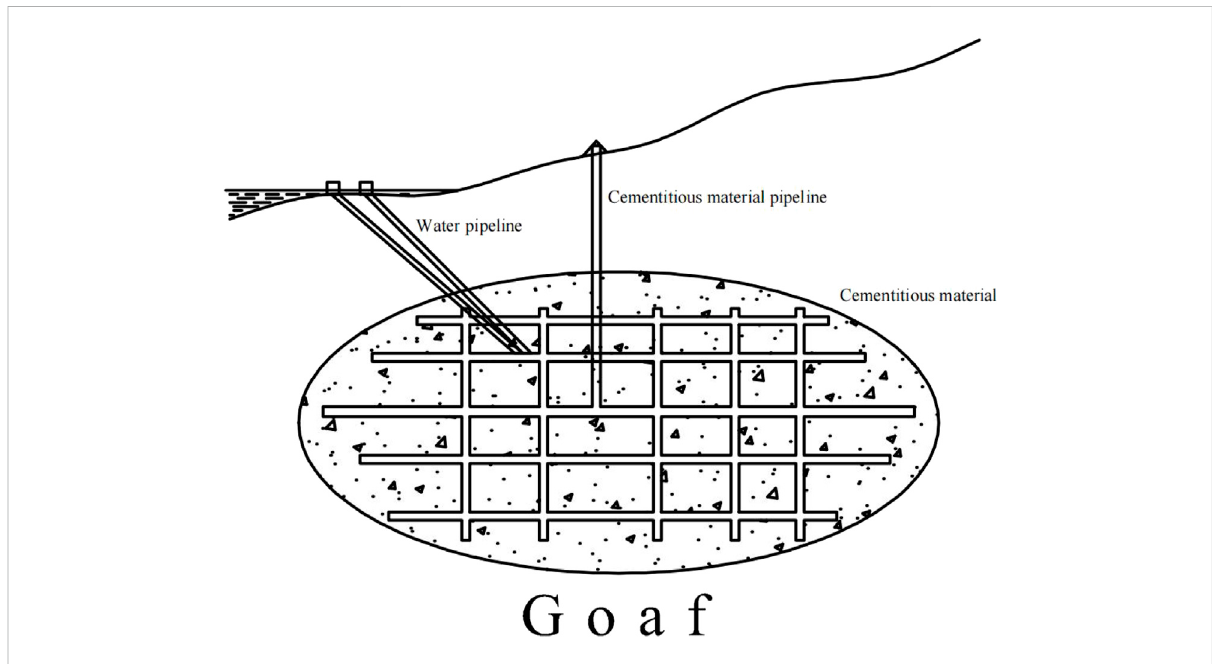
FIGURE 1 Schematic diagram of goaf fi